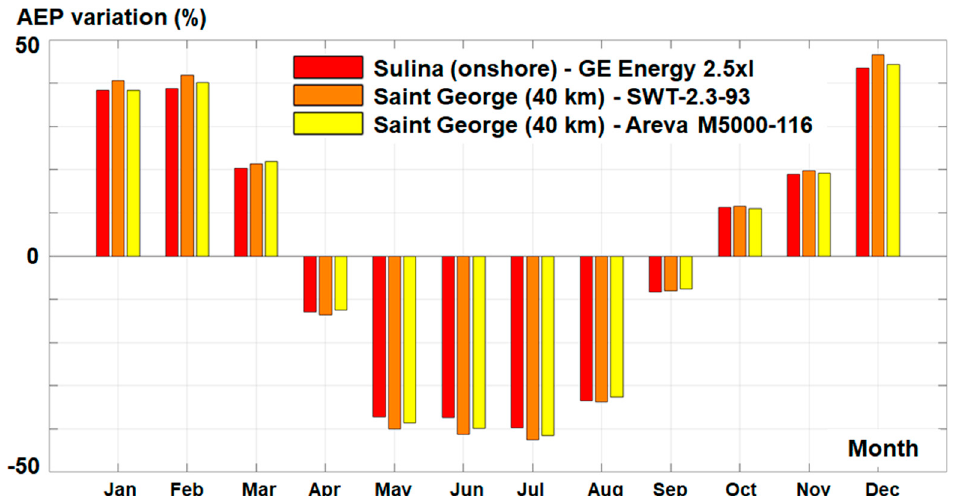
Figure 8. Monthly AEP variations considering as a reference the total time average values, indicated for Sulina onshore (0 km) and Saint George (40 km from the shore).